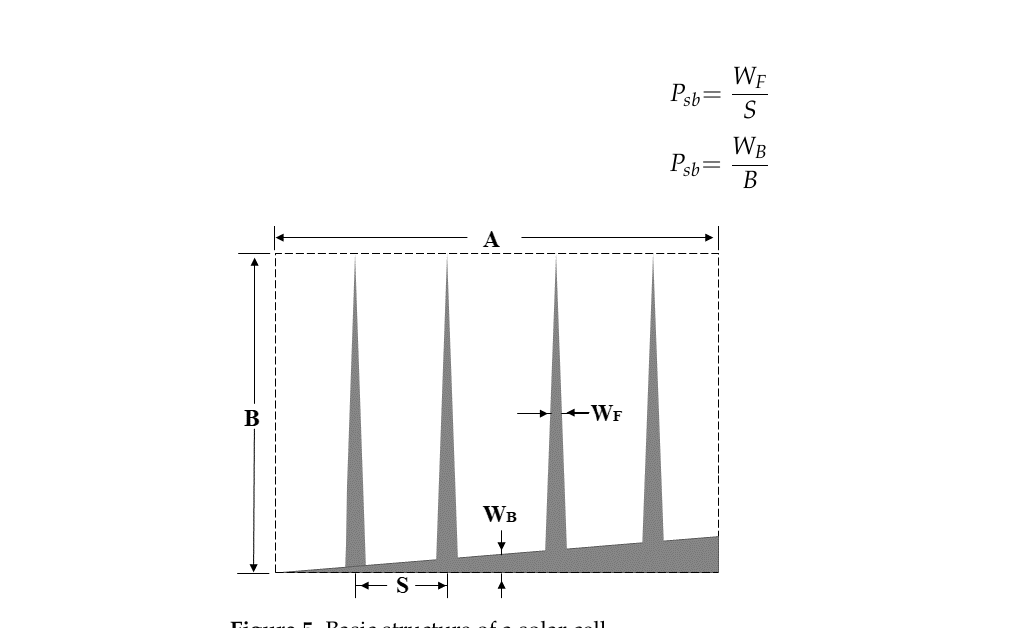
Figure 5. Basic structure of a solar cell.